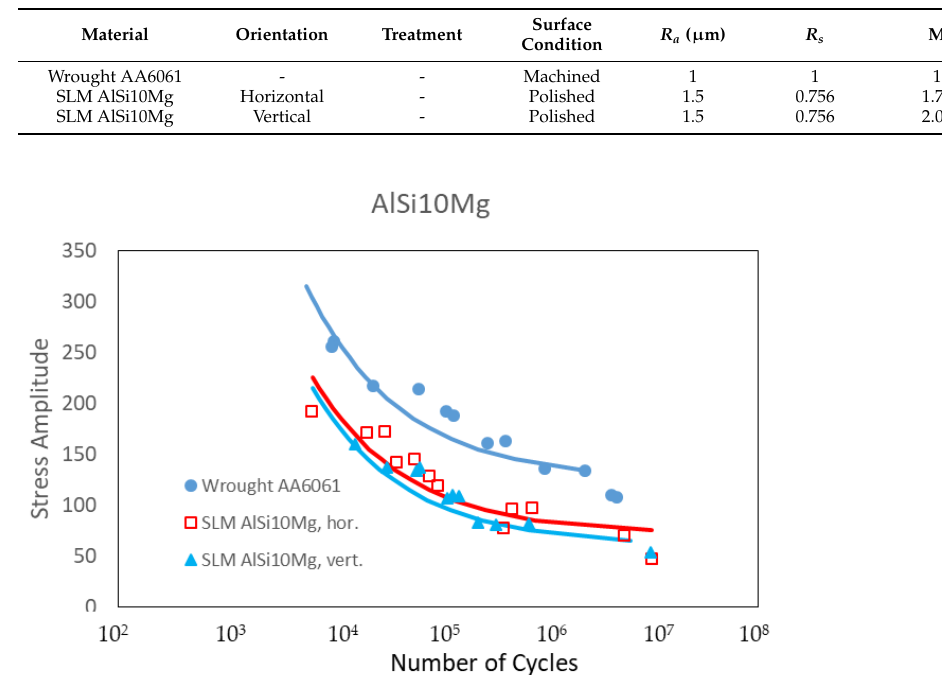
Table 9. Surface finish and microstructural factors for AlSi10Mg ( σ 0 = 125 MPa).